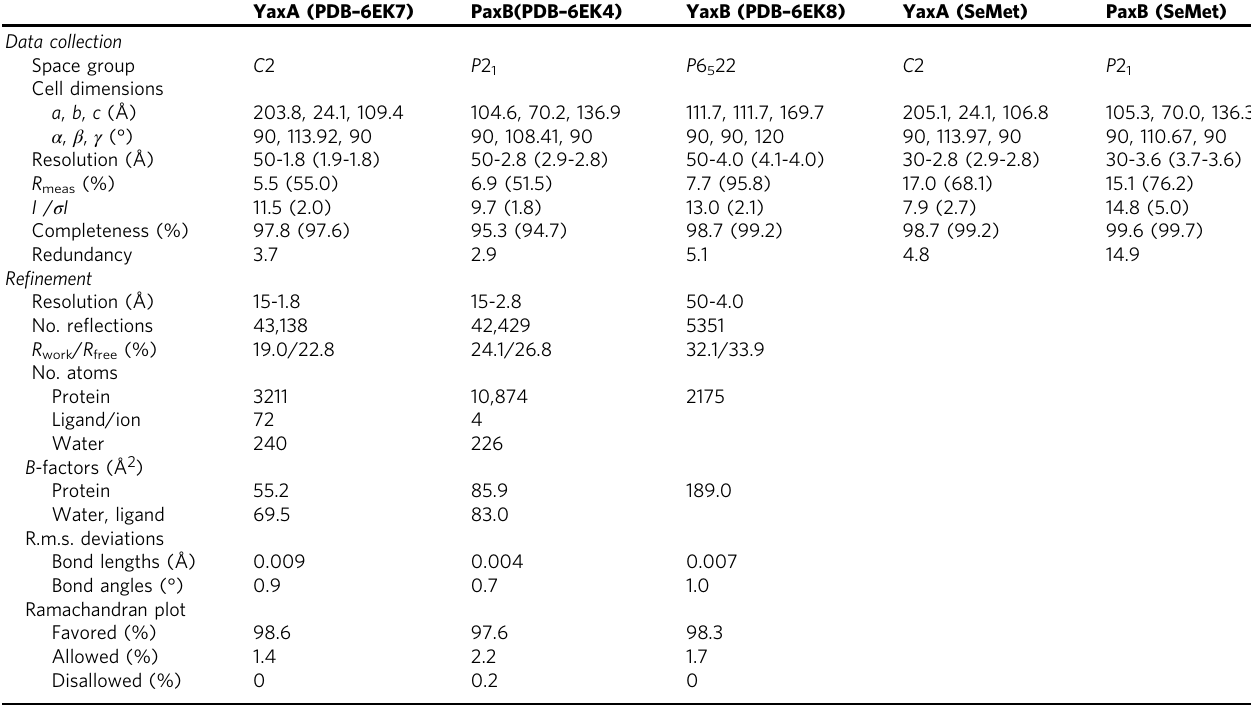
Table 1 X-ray data collection and re fi nement